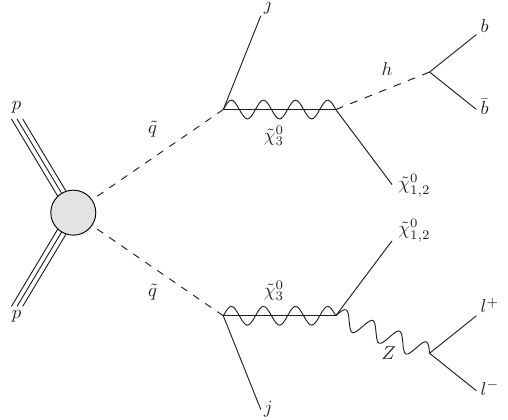
Figure 1. Representative Feynman diagram corresponding to our signature with 2 l + 2 b + 2 j + E miss in the final